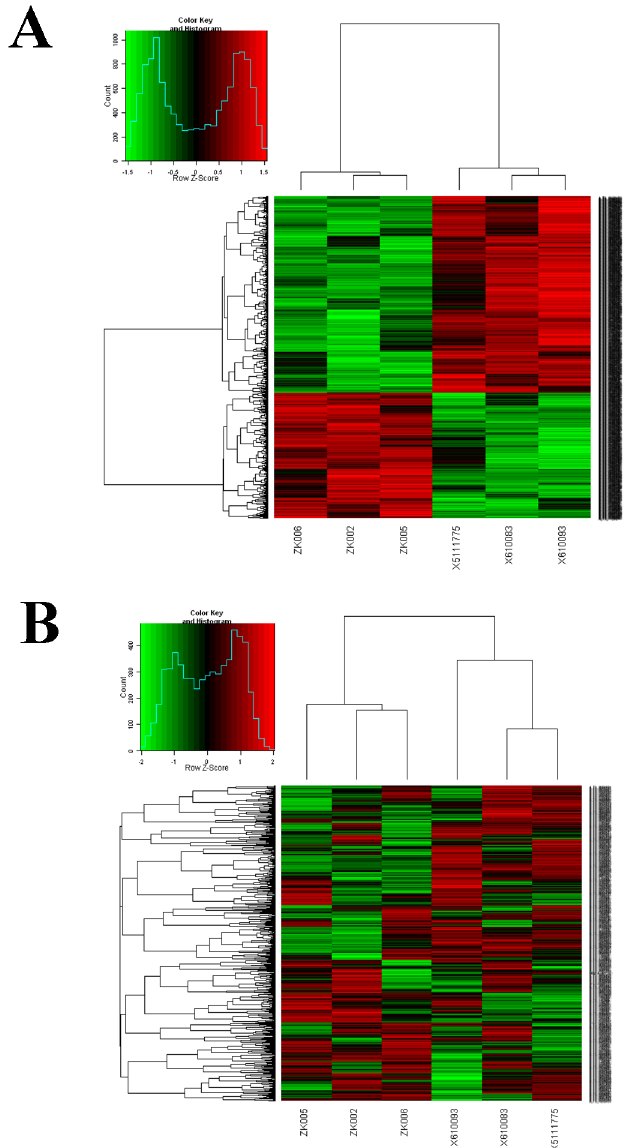
Fig 1. The hierarchical clustering analysis of fat-1 transgenic cattle and wild-type cattle. (A) The heat- map of the 2042 differentially expressed genes. (B) The heat-map of the top 1000 expressed genes. The columns and rows in the heat maps represent samples and genes, respectively. Sample names are displayed below the heat